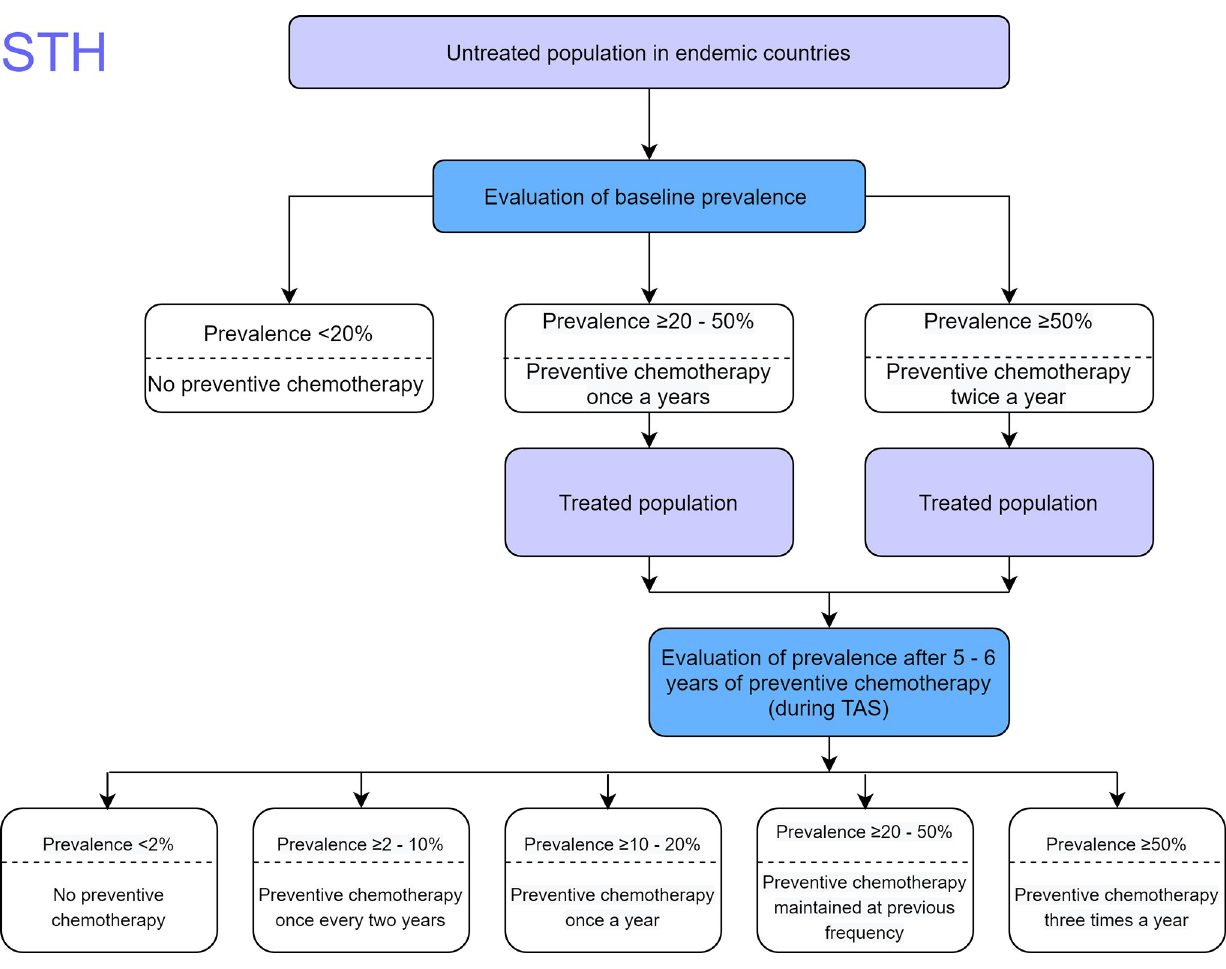
Fig 4. WHO guidelines decision tree for STH infections after five to six years of